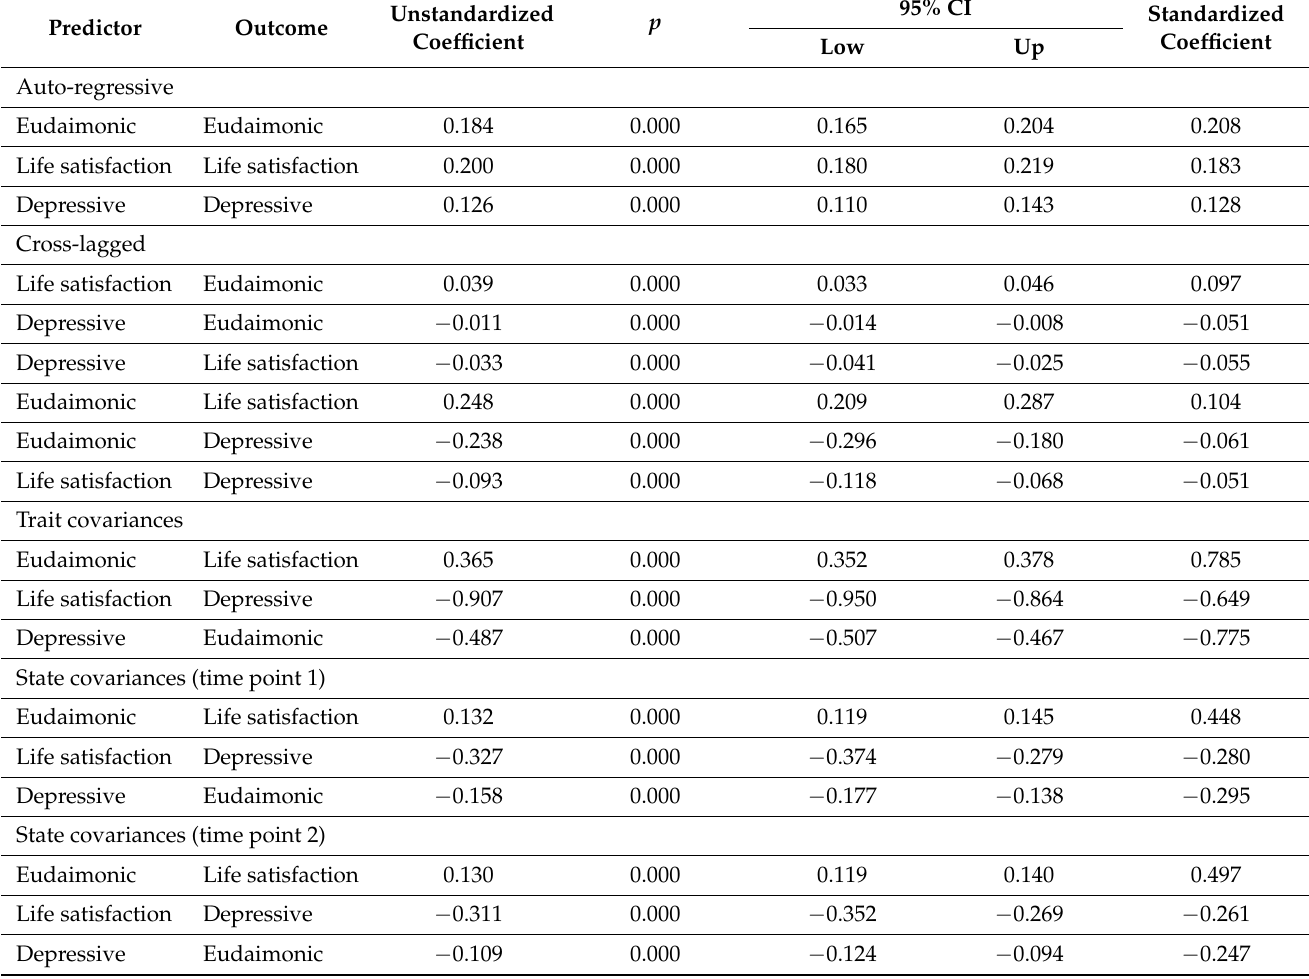
Table 4. Parameter Estimates for